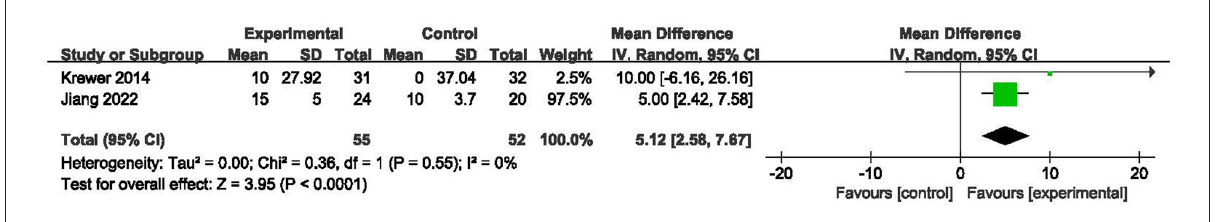
FIGURE7 Meta-analysis of the effect of rPMS on activities of daily living measured with Barthel